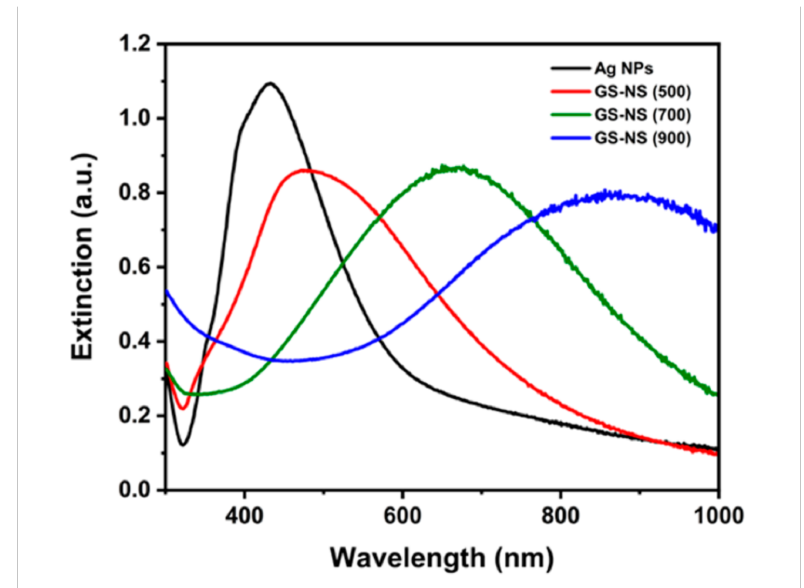
Figure 2. Extinction spectra of Ag NPs and gold-silver nanoshells having LSPR maxima at 500, 700, and 900 nm, denoted as GS-NS (500), GS-NS (700), and GS-NS (900). LSPR = localized surface plasmon